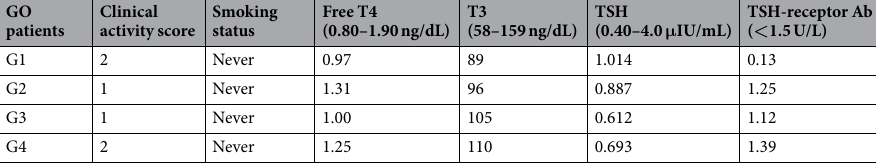
Table 1. Clinical characteristics of the four GO patients before surgery in this